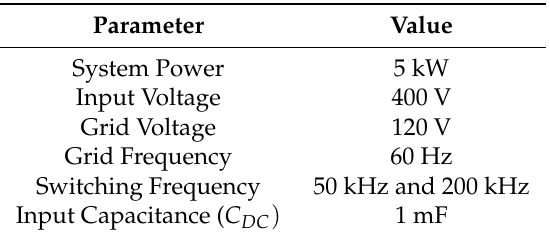
Table 4. Simulation